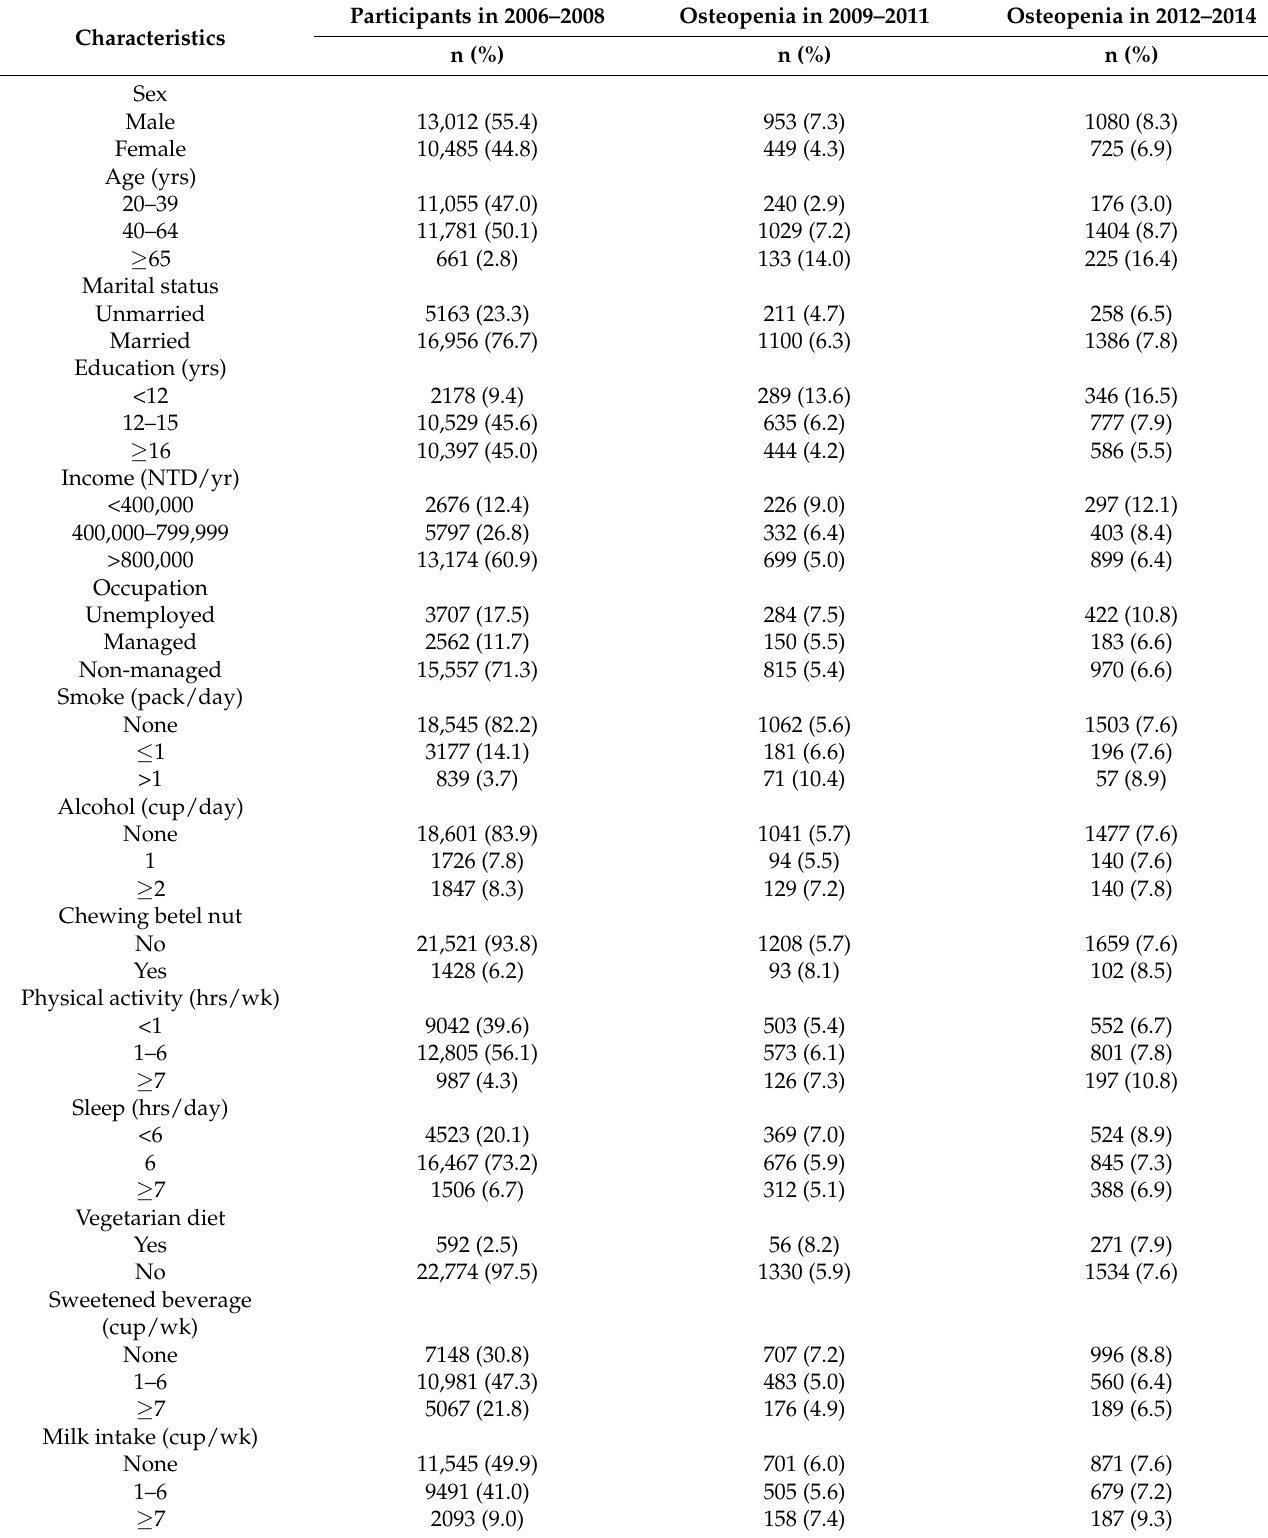
Table 2. Explanatory variables related to osteopenia over the three study